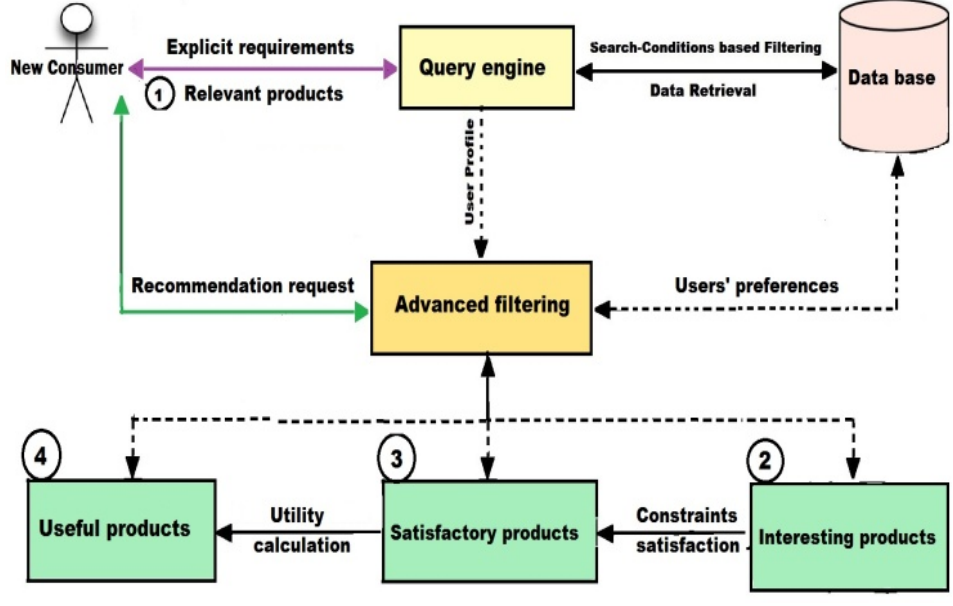
Figure 5. The recommendations